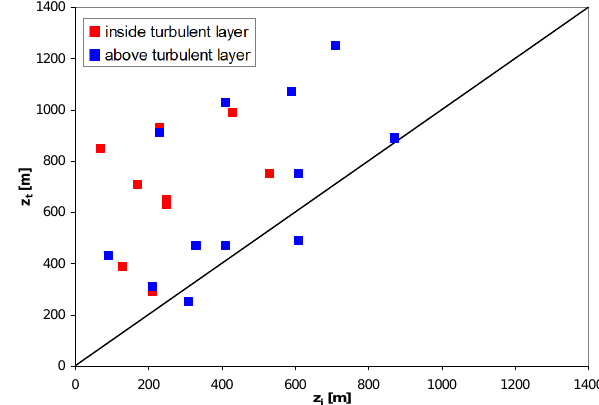
Fig. 7. A comparison of the height of the jet core, z j , and height of the turbulent layer, z Ri . LLJs are divided into groups of higher and lower than average U j . Also four cases are shown where the inversion base temperature ( T b ) is less than − 15 ◦ C (these cases belong to the higher U j group).